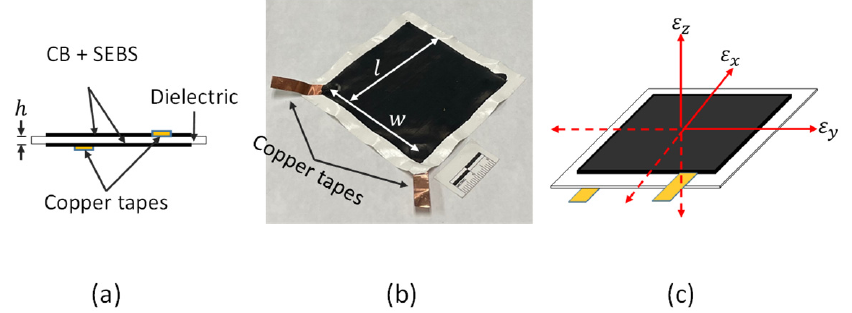
Figure 2 . Illustration of the SEC sensor with the principal axes of strains: ( a ) structure of SEC, ( b ) ( b ) picture of an SEC, and ( c ) SEC with the principal axes of picture of an SEC, and ( c ) SEC with the principal axes of strains .